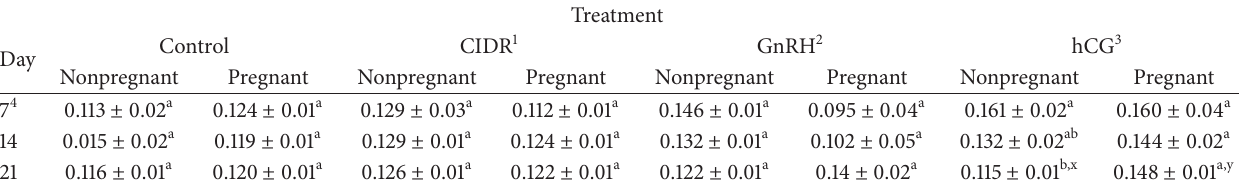
Table 2: LSMeans and standard errors for concentrations of TNF- 𝛼 (pg/mL) in nonpregnant and pregnant cows within treatments. Treatment